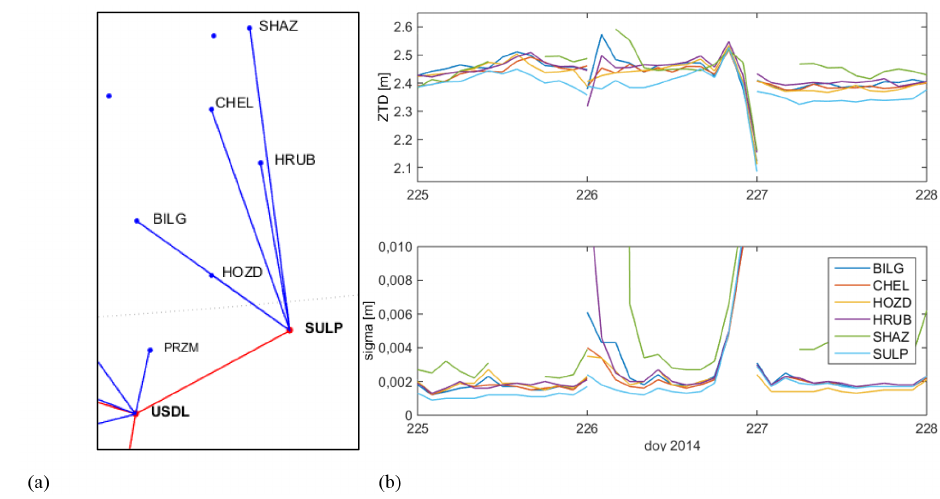
Figure 2. Example of common mode biases in ZTD affecting a cluster of stations (SULP, BILG, CHEL, HOZD, HRUB, SHAZ) due to disconnection from the reference network. (a) In this network design the cluster is connected to the main network through a single baseline SULP-USDL. (b) A data gap at station USDL on day 226 after 18:52UTC provokes a common mode bias at all stations of the